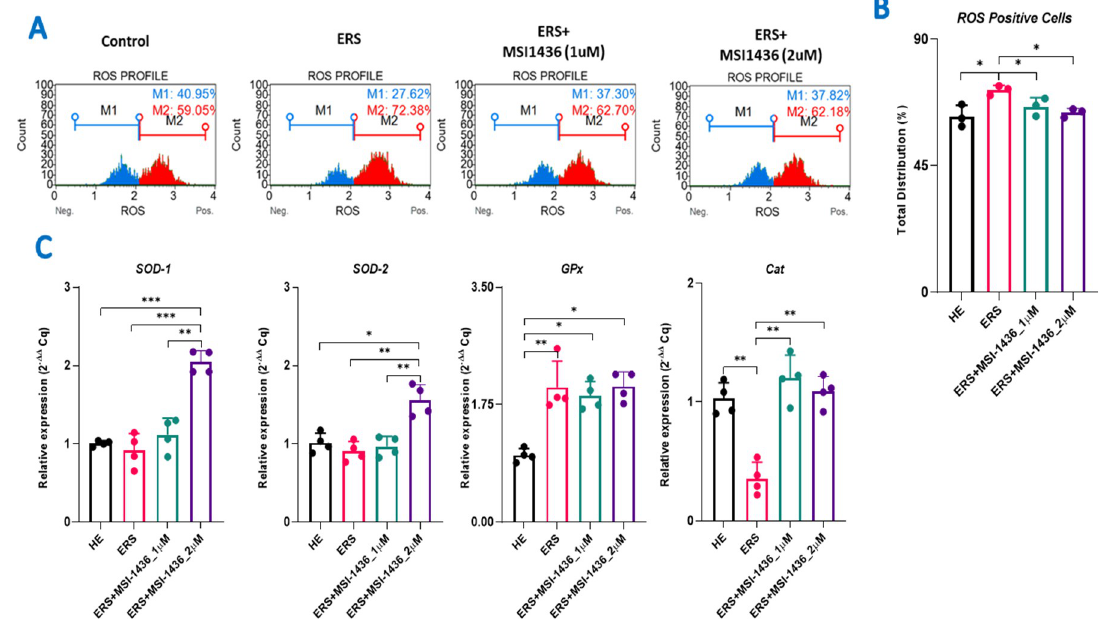
Fig 4. MSI-1436 compound alleviates oxidative stress in TM-treated HepG2 cells. ( A ) Representative plots of cells stained with DHE evaluated using a flow cytometer. ( B ) Bar charts summarizing the total intracellular ROS positive cells. ( C ) Representative bar charts of endogenous antioxidant enzymes-related transcripts. The results are expressed as the mean of 3 different experiments ± SD. Asterisks refer to a significant difference between two groups, where: p < 0.05 ( � ); p < 0.01( �� ); p < 0.001 ( ��� ); p < 0.0001 ( ���� ). HE: Healthy untreated HepG2 cells; ERS: Endoplasmic reticulum-stressed cells; ERS+MSI: Groups pretreated with MSI-1436 compound before inducing ERS.